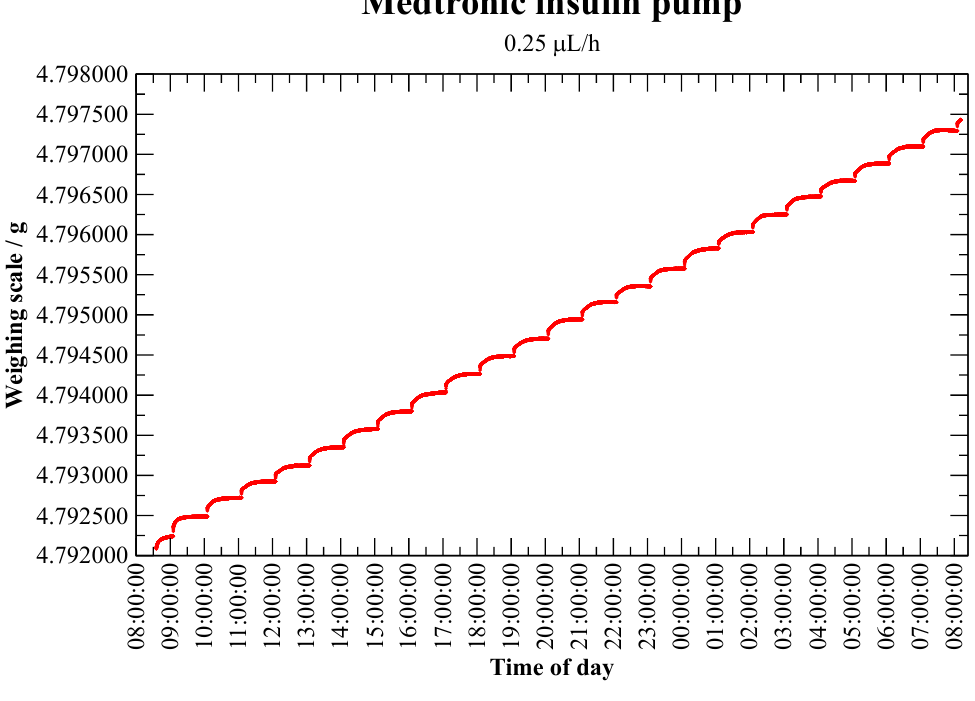
Figure 9. Measurement results of the Medtronic insulin pump for measurements over one day (24h) for a preset flow rate of 0.025Uh − 1 (0.25µLh − 1